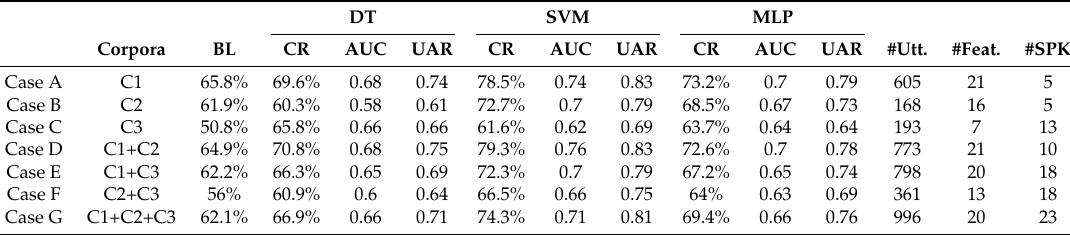
Table 3. Classification results depending on the corpus and the classifier used. The prosody expert judgments were used to train the classifiers. This table shows the performance baseline (BL) of each group of samples (number of samples of the most populated class divided by all the samples), Decision trees (DT), Support vector machines (SVM), Multilayer Perceptron (MLP), classification rate (CR), Area Under the Curve (AUC) and Unweighted Average Recall (UAR). The number of samples (utt.), the number of speakers (SPK) and the number of features (Feat.) are presented. The output of the different classifiers are Right or Wrong, based on prosody expert